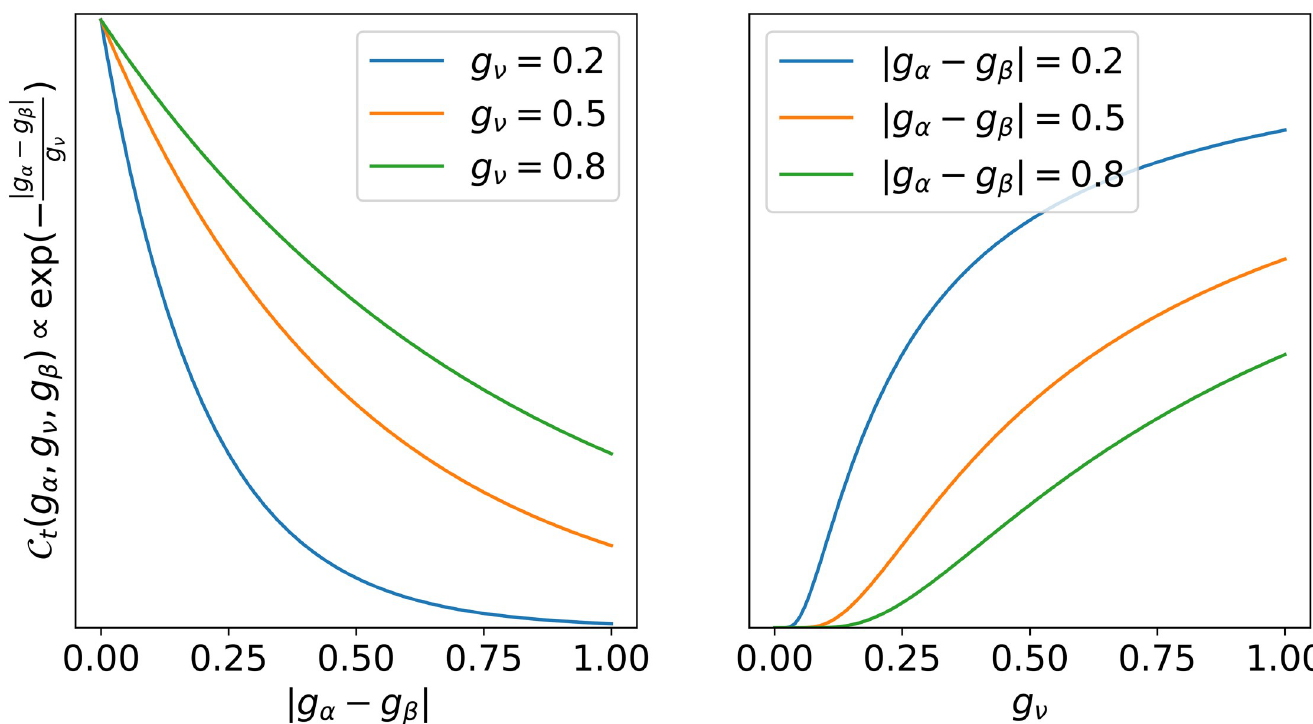
Fig 1. Trade-off based compatibility function C and low otherwise. The right panel shows how C